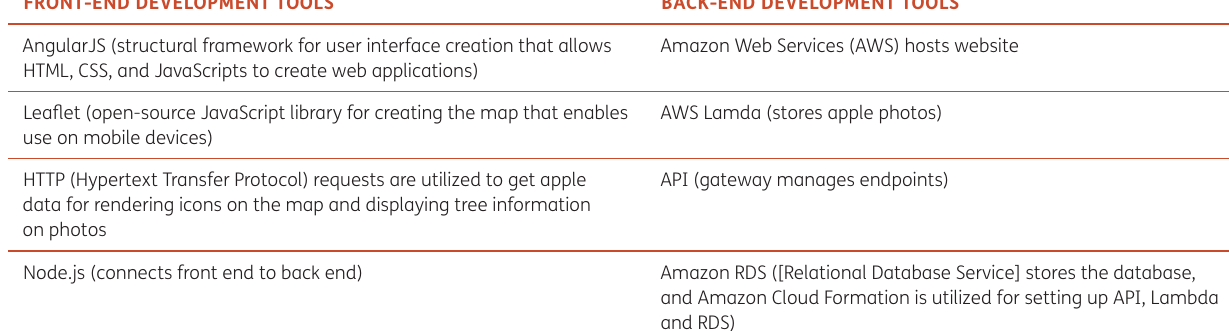
Table 4 Summary of tools utilized by Team Eden Crashers for the development of the interactive